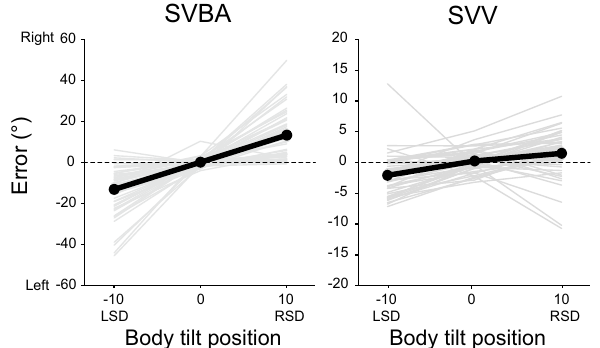
Figure 1. Adjustment errors in the No-OKS conditions at each tilt position for the subjective visual body axis (SVBA) and subjective visual vertical (SVV) tasks. Gray-colored lines represent the averaged error of each participant, and black-colored lines represent errors averaged across all participants. LSD left-side-down, RSD